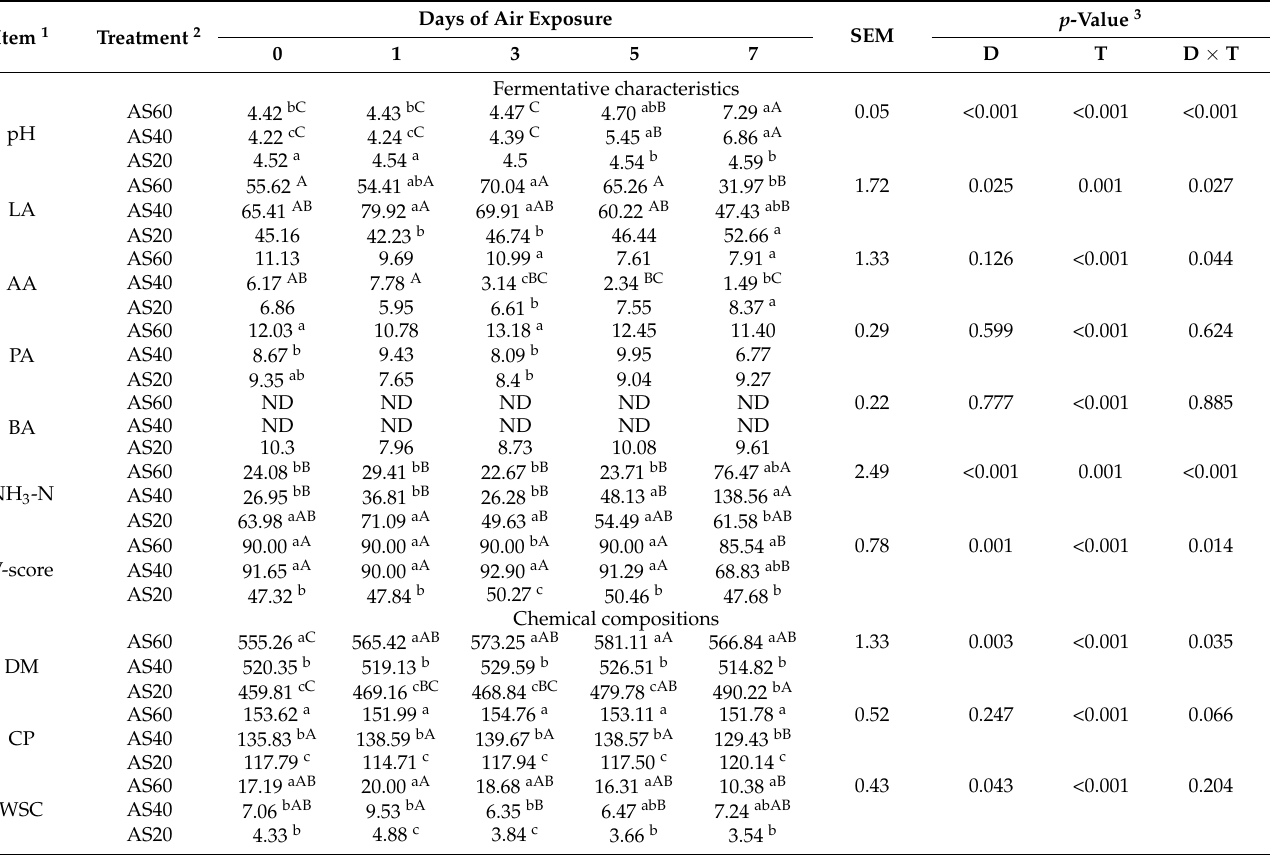
Table 5. Changes in fermentative characteristics and chemical compositions of the TMR silages after exposure to air.